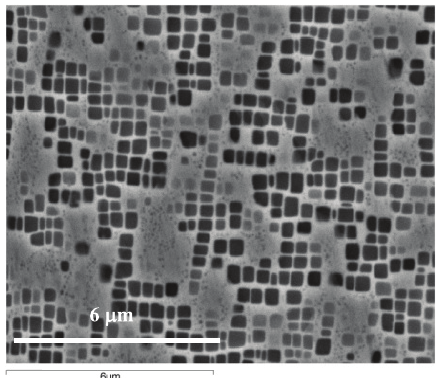
Figure 14. Microstructure of specimen after standard heat treatment showing fine (cid:2) 0